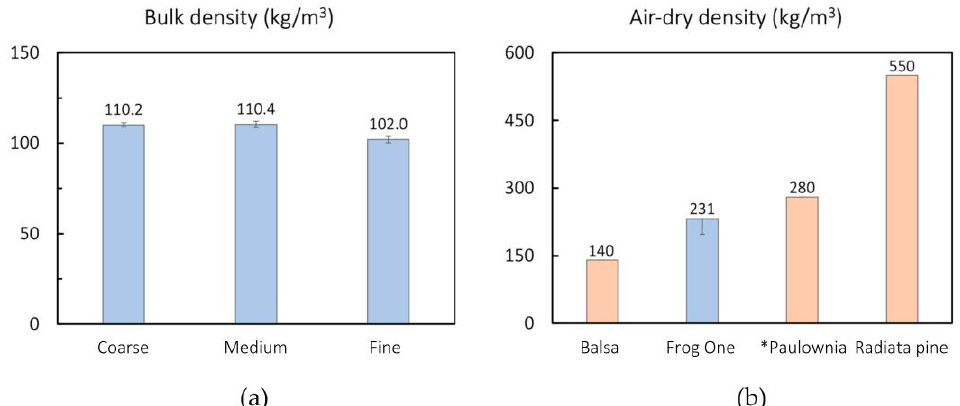
Figure 7. Average bulk density per particle size category obtained through three repeated measure- ments ( a ); average air-dry density ( ADD ) of Frog One hemp (15 specimen) compared to average ADD values of commercial timbers. Data obtained from [38] and * [39] ( b ). Error bars indicate standard deviations.